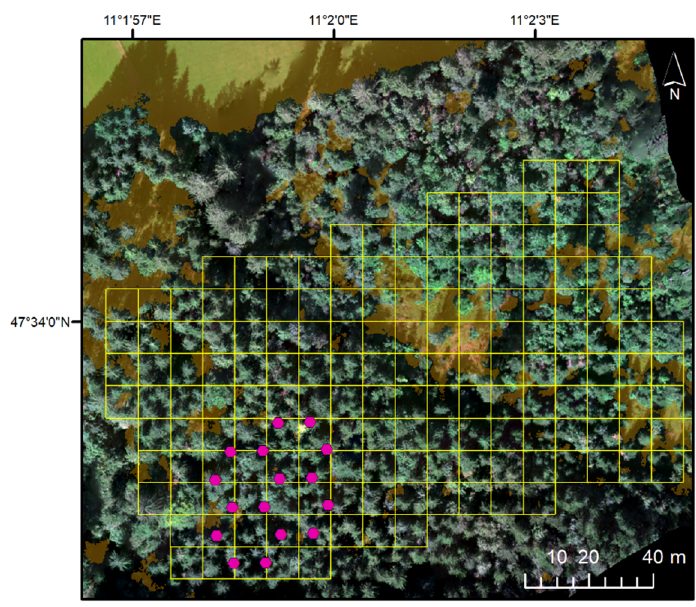
Figure 2. Spatial extents of remote sensing and in situ products: UAV orthophoto from 12 September 2018 with WSN (pink hexagons), footprints of S2 pixels (yellow outlines) and UAV-derived ground mask (assumption NA = vegetation, shown in transparent brown) for FCOVER retrieval.